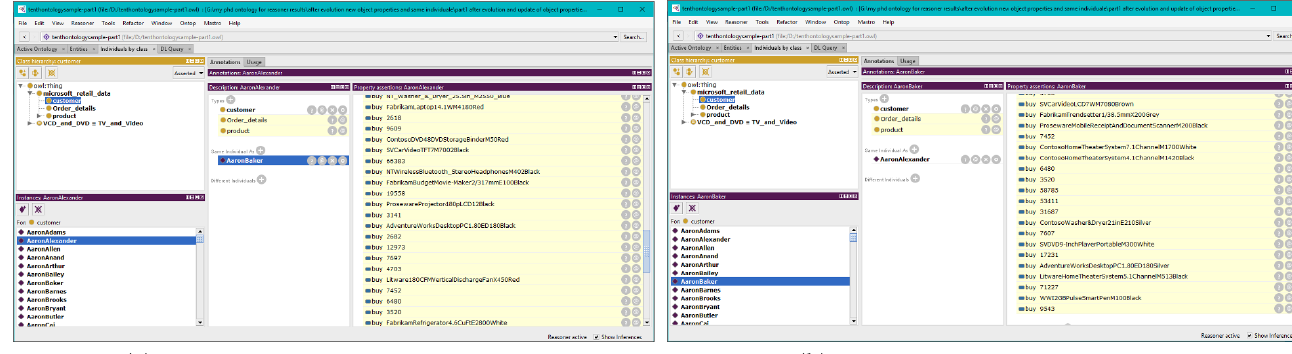
Figure 11. Reasoner results after